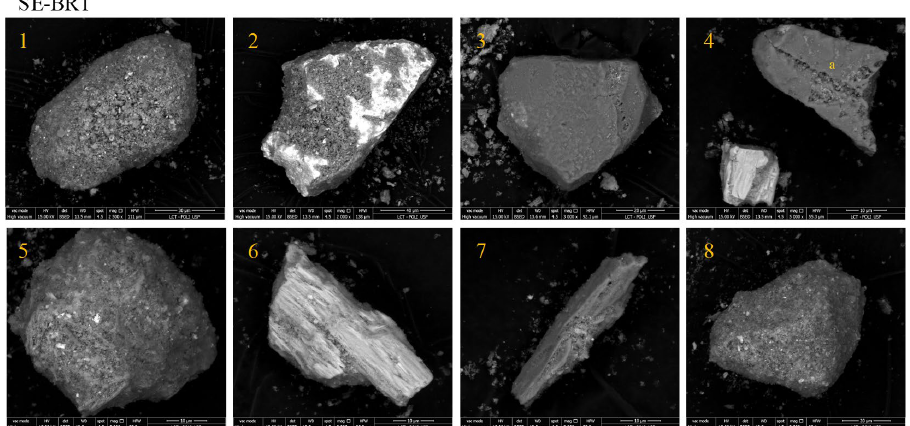
Figure 5. SEM images of SE-BR1. EDS illustrates the presence of: 1 and 8 - Al, Si, Na; 2 – Zr, Si, Fe; 3 - Si; 4a – Si; 5 – Al, Si, Fe, Na; 6 – Fe, Al, Na, Ti; 7 – Al, Si, K.